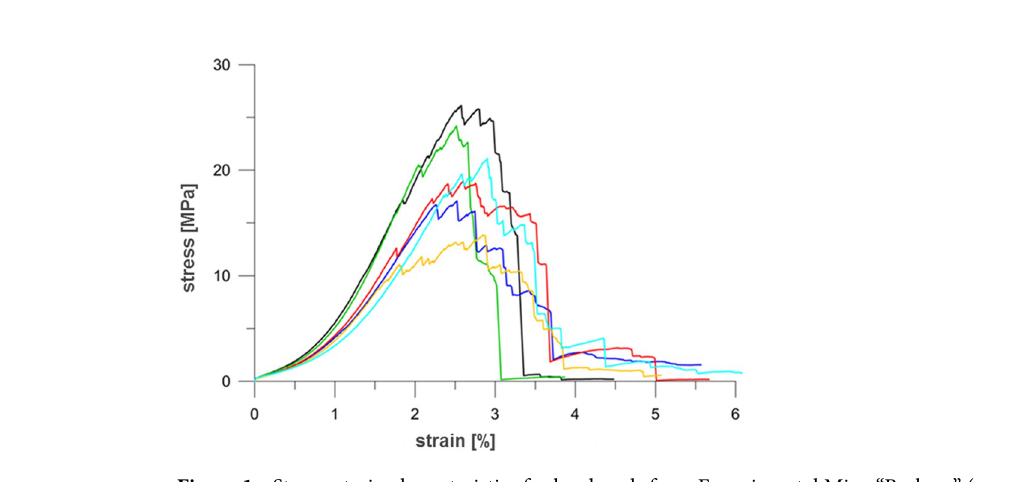
Figure 1. Stress–strain characteristics for hard coals from Experimental Mine “Barbara” (sample: 1/1-black, 1/2-green, 1/3-dark blue, 1/4-red, 1/5-yellow, 1/6-light blue).